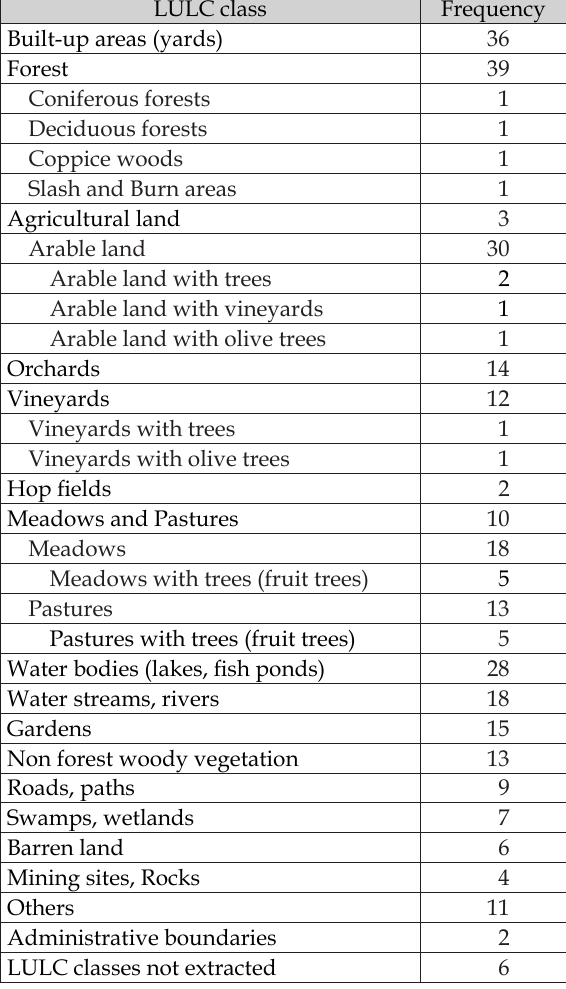
Table 1. Frequency table of LULC classes.